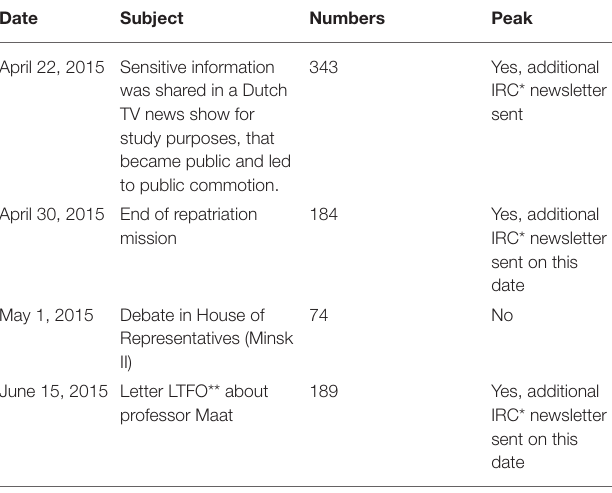
TABLE 5 | IRC* Google Analytics data (Data source E) visitation